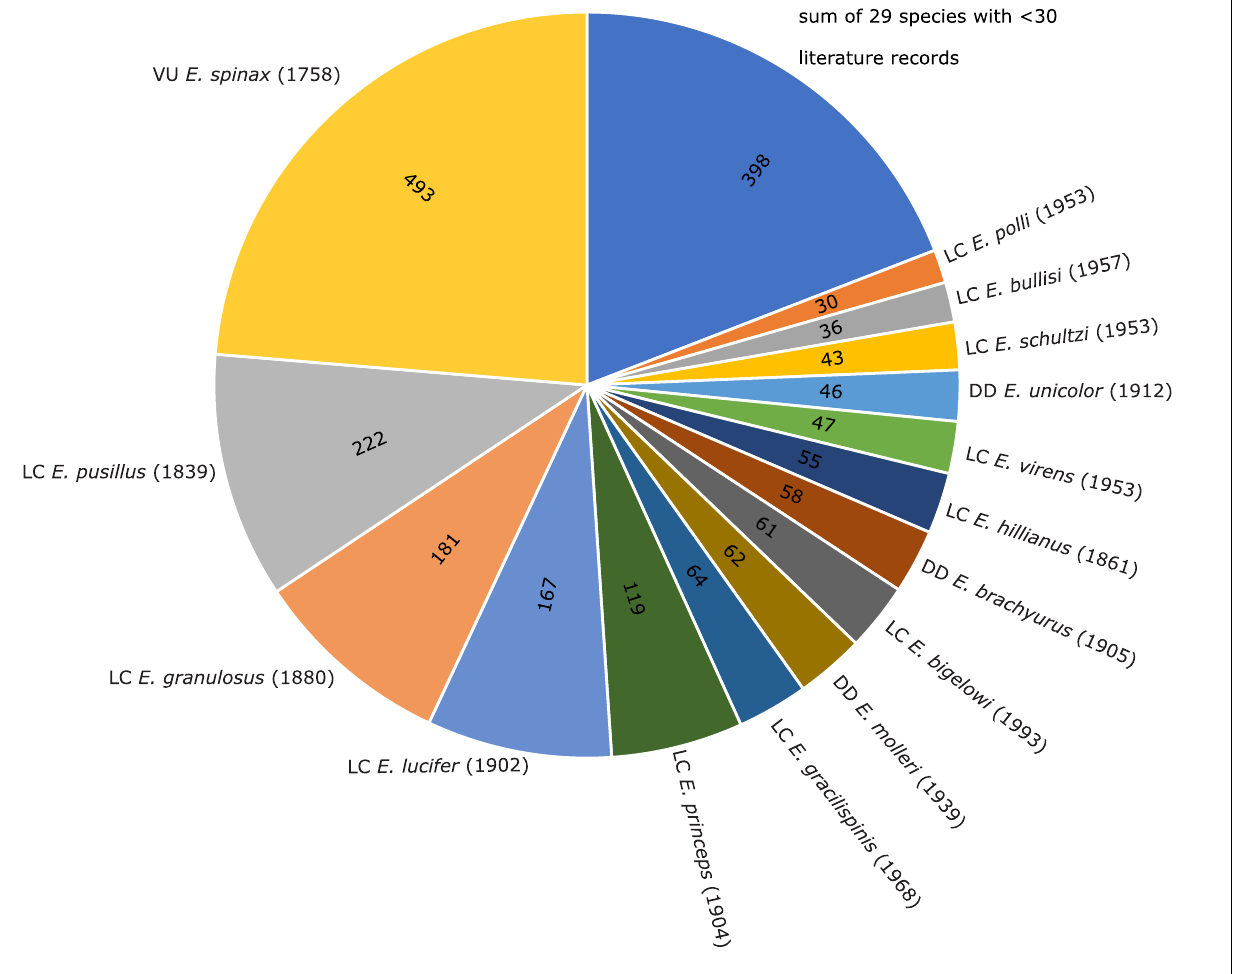
FIGURE 1 | Pie chart showing the number of scientific publications listed per Etmopterus species in the bibliographic database Shark References. Species with a total number of publications below 30 are summarised. Global IUCN Red List of Threatened Species status (VU = vulnerable; LC = least concern; DD = data deficient) is given in front of species names, year of description in